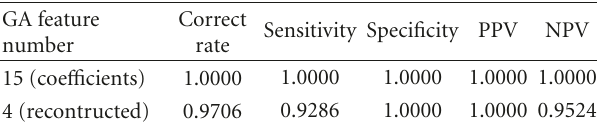
Table 5: Performance of selected GA features. This table shows performance of leukemia (ALL versus AML) dataset. PPV stands for positive predictive value; NPV stands for negative predictive value.